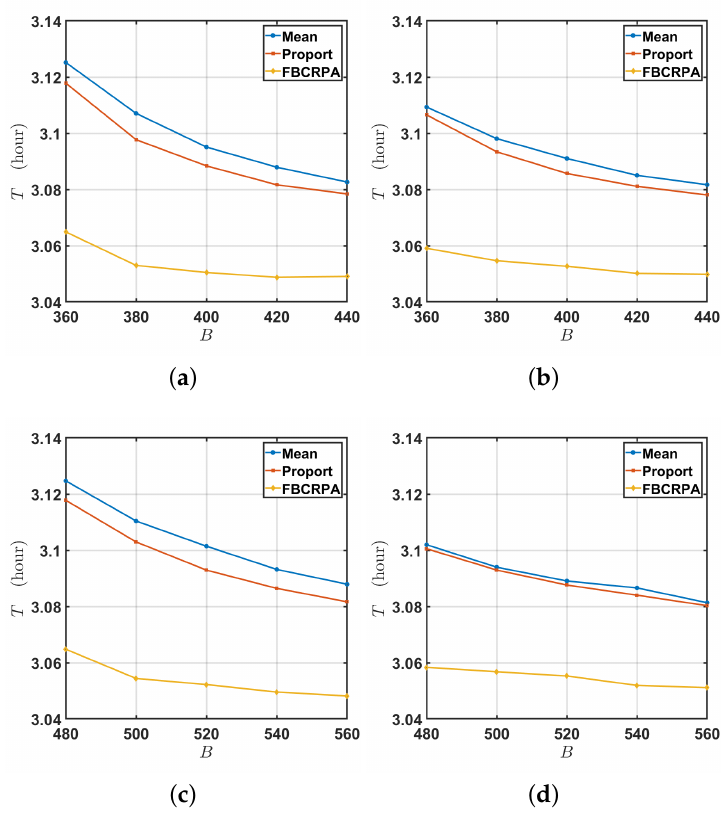
Figure 6. Relationship between T and budget under different M . ( a ) D = 0%, M = 0.5. ( b ) D = 50%, M = 0.5. ( c ) D = 0%, M = 1. ( d ) D = 50%, M =